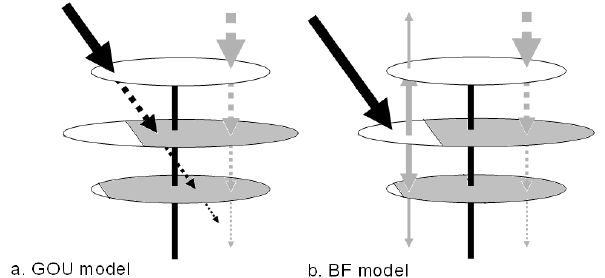
Figure 1. Diagram of the radiation interception in the two different models: GOU (Goudriaan, 1977) and our new model (BF). Both the GOU (a) and BF model (b) simulate the fraction of sunlit leaves (white areas) to shaded leaves (grey areas) in the same way according to Lambert-Beer’s law. The absorption of incoming diffuse radiation (broken grey arrows) is also simulated the same way with incoming diffuse radiation being absorbed by both sunlit and shaded leaves also following Lambert-Beer’s law. The difference between the models lies in the fluxes of scattered radiation, which in the BF model are generated by the transmittance and reflectance of beam radiation (black arrows) at all levels of the canopy. The GOU model approximates the total interception of incoming direct radiation (broken black arrow) with a single aggregated flux that includes both the interception of beam radiation and the scattered radiation generated by the beam radiation. Scattered radiation is then calculated at each level as the difference between total direct radiation (black arrow) and beam radiation (based on the area of sunlit leaves). In the BF model, scattered radiation is generated by beam radiation (black arrow) being intercepted by sunlit leaves and scattered into one up- and one downstream (solid grey arrows) of scattered (diffuse) radiation.